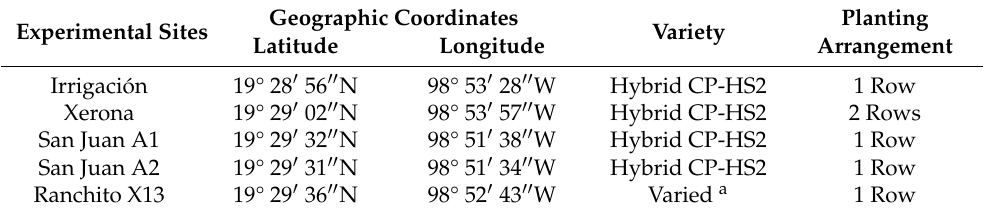
Figure 1. Location and distribution of experimental sites. Table 1. Data capture